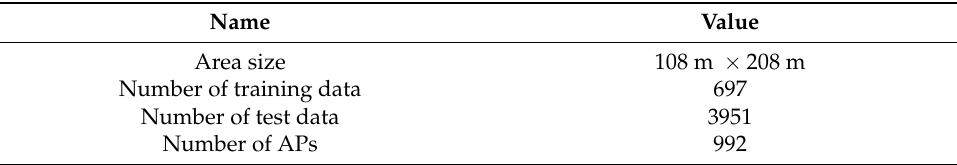
Table 1. TUT Wi-Fi fingerprint dataset about ground floor.